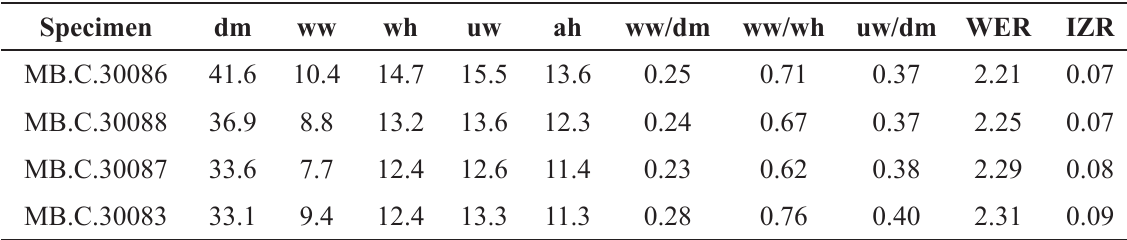
Table 34. Conch dimensions (partly estimated) and ratios of selected specimens of Abichites infirmis Korn & Hairapetian sp. nov. from Baghuk